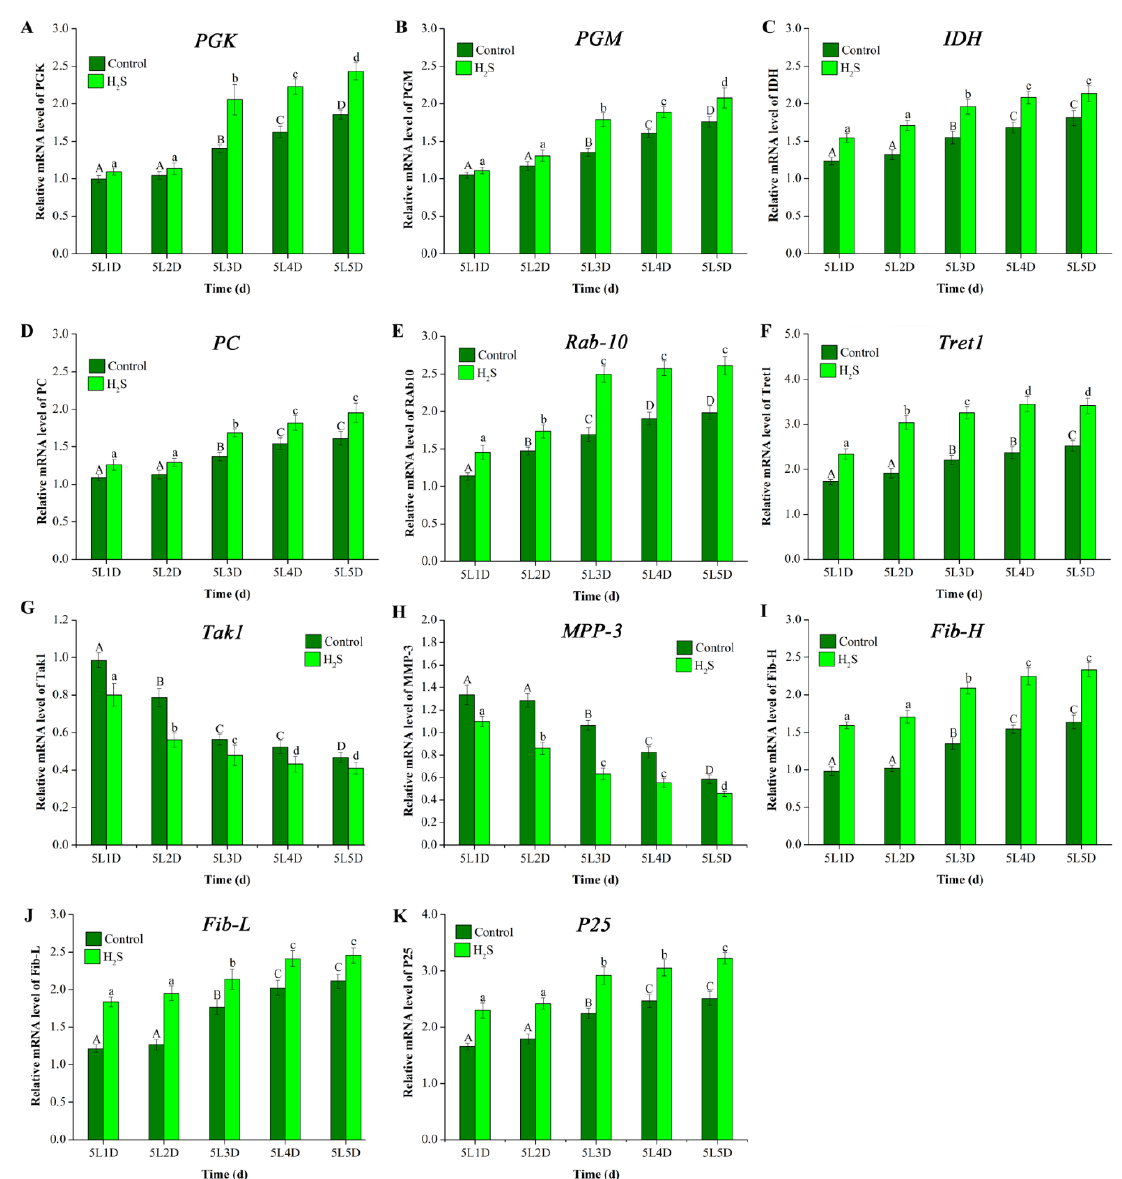
Figure 5. Expression changes of 10 DEGs after H 2 S exposure at different time points in the 5th instar larvae (5L1D, 5L2D, 5L3D, 5L4D, and 5L5D). ( A ) PGK; ( B ) PGM; ( C ) IDH; ( D ) PC; ( E ) Rab-10; ( F ) Tret1; ( G ) Tak1; ( H ) MPP-3; ( I ) Fib-H; ( J ) Fib-L; and ( K ) P25. The lowercase letters (a, b, c, and d) represent the significant difference at p ≤ 0.05 among the expression levels at different times of the H 2 S treated group; the uppercase letters (A, B, C, and D) represent the significant difference at p ≤ 0.05 among the expression levels at different times of the control group. The full names of abbreviations of genes are listed in Table S1.